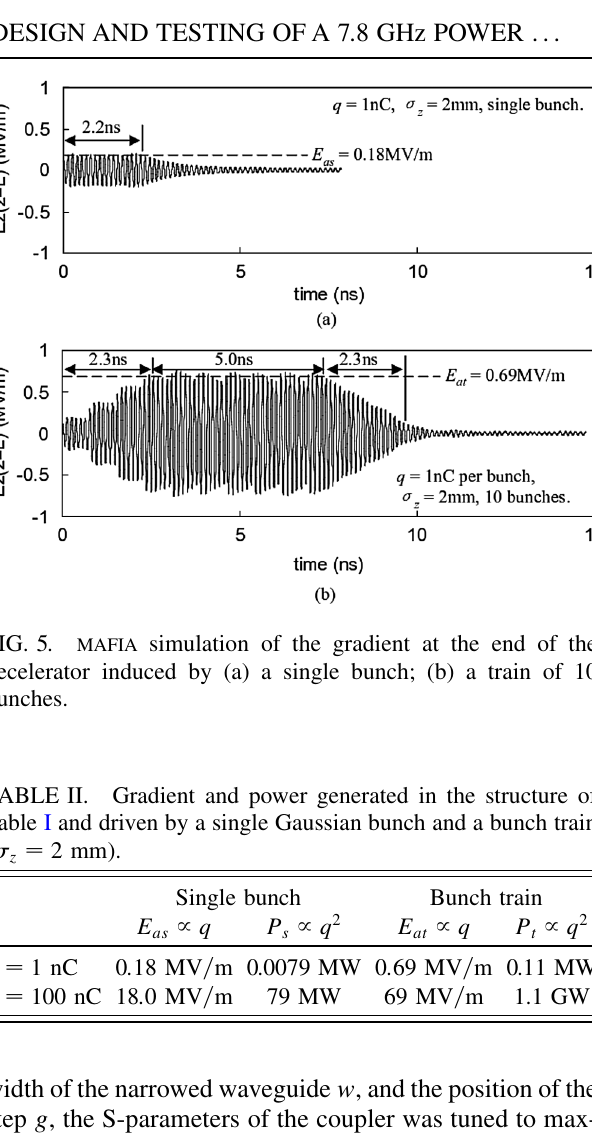
- TE coupler with 01 10